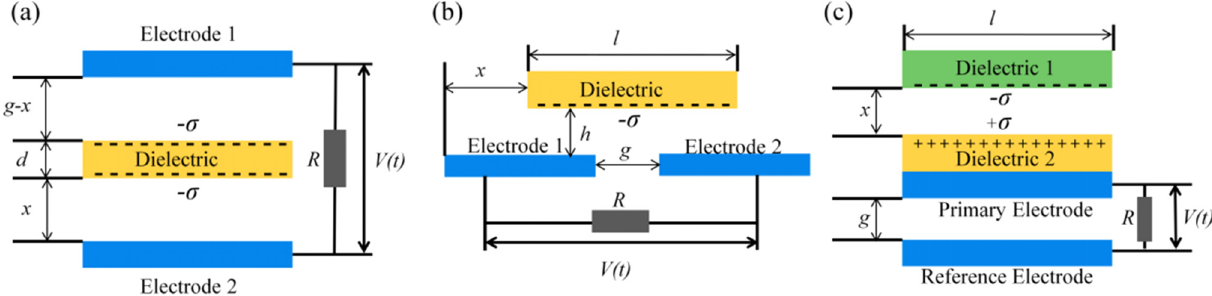
Figure 3: Typical models of a ( a ) dielectric CFTENG, ( b ) dielectric SFTENG, and ( c ) dielectric - to - dielectric contact - mode SETENG [ 46,47